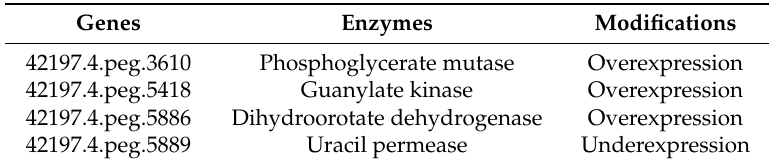
Table 4. The predicted modification of A. pretiosum ATCC 31280 for AP-3 overproduction. Genes